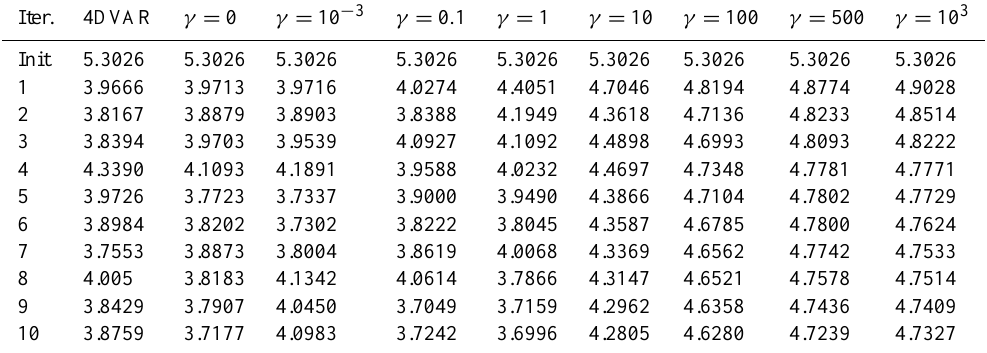
Table 3. RMSE values calculated by Eq. (34) along the incremental 4DVAR and EnKS-4DVAR iterations for different values of the regular- ization parameter γ , for the two-level quasi-geostrophic model (Sect. 5.2.2). Iter.